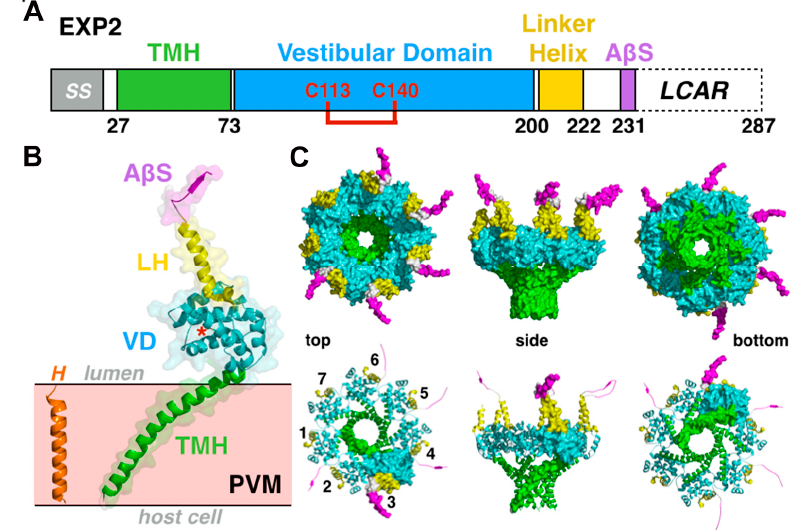
Figure 3. The protein-conducting pore-forming protein EXP2. ( A ) Schematic organization of EXP2 including: SS, signal sequence; TMH, transmembrane helix; VD, vestibular domain; LH, linker helix; A β S, assembly β -strand; LCAR, low-complexity acidic region and the strictly conserved disulfide bond between residues C113 and C140. ( B ) EXP2 protomer structure in transparent surface representation. The red asterisk marks the position of the strictly conserved disulfide bond. A canonical TMH perpendicular (H) to the plane of the membrane is shown as a comparison with the highly tilted and longer TMH of EXP2. ( C ) Heptameric arrangement of the EXP2 transmembrane protein-conducting pore shown from the top (vacuolar lumen), side (membrane plane), and bottom (host cell cytoplasm)